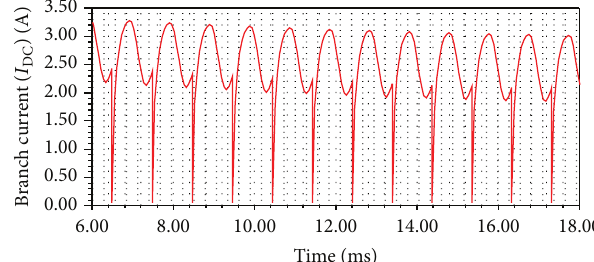
Figure 6: The DC link current (without filter).